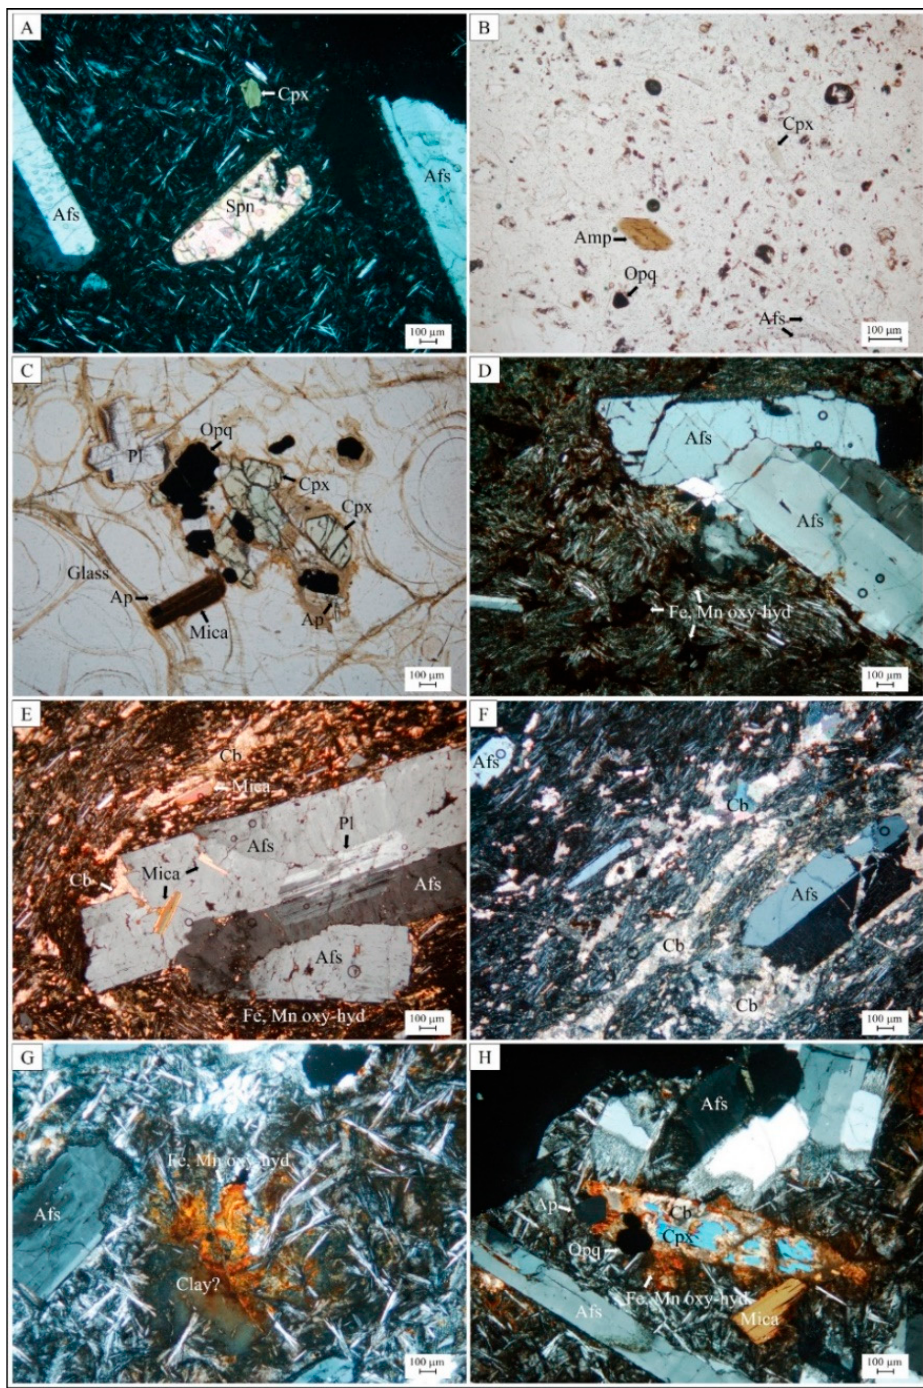
Figure 2. Selected thin section photomicrographs of the investigated MEGT samples; additional photomicrographs are provided in Supplementary Figure S1. Key for mineral names (abbreviated according to Whitney and Evans, 2010 [48], except for Fe, Mn oxy-hydroxides, abbreviated as Fe, Mn oxy-hyd): Afs = alkali-feldspar; Cpx = clinopyroxene; Pl = plagioclase; Opq = opaque oxide; Spn = sphene; Ap = apatite; Amp = amphibole; Cb = carbonate. ( A ) fresh scoria showing porphyritic texture and microcrystalline/felty groundmass (cross-polarised light; sample OIS0102); ( B ) fresh scoria showing porphyritic texture and microcrystalline/felty groundmass (plane-polarised light; sample OIS0102); ( C ) gabbroic agglomerate in vitrophyric obsidian, showing the typical perlitic fractures;